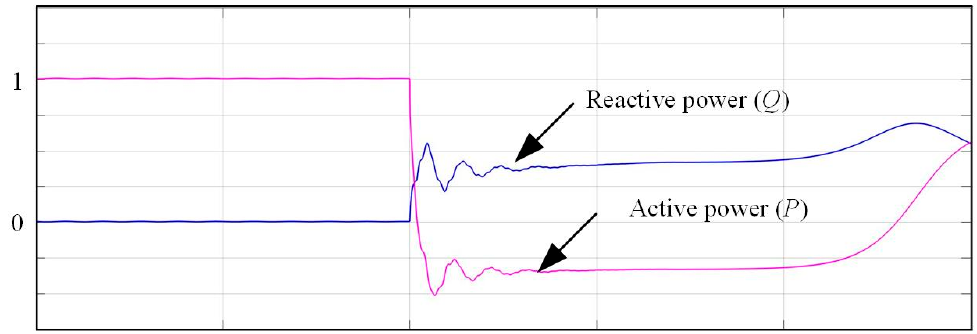
Figure 8. Waveforms of active and reactive power with 30% voltage drop ( t : 0.5 s/div).